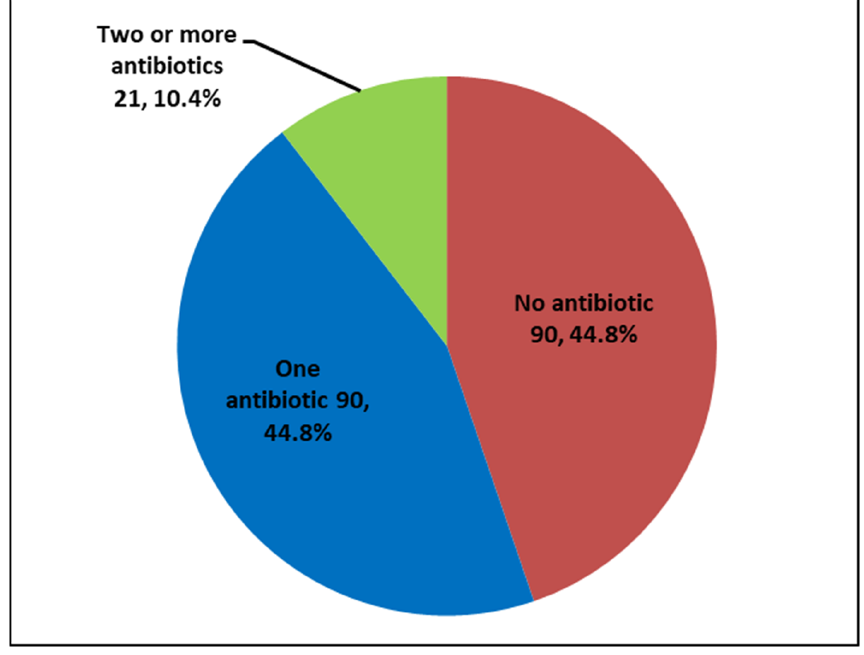
Figure 2. Number and proportion of patients who received a prescription of topical antibiotics.